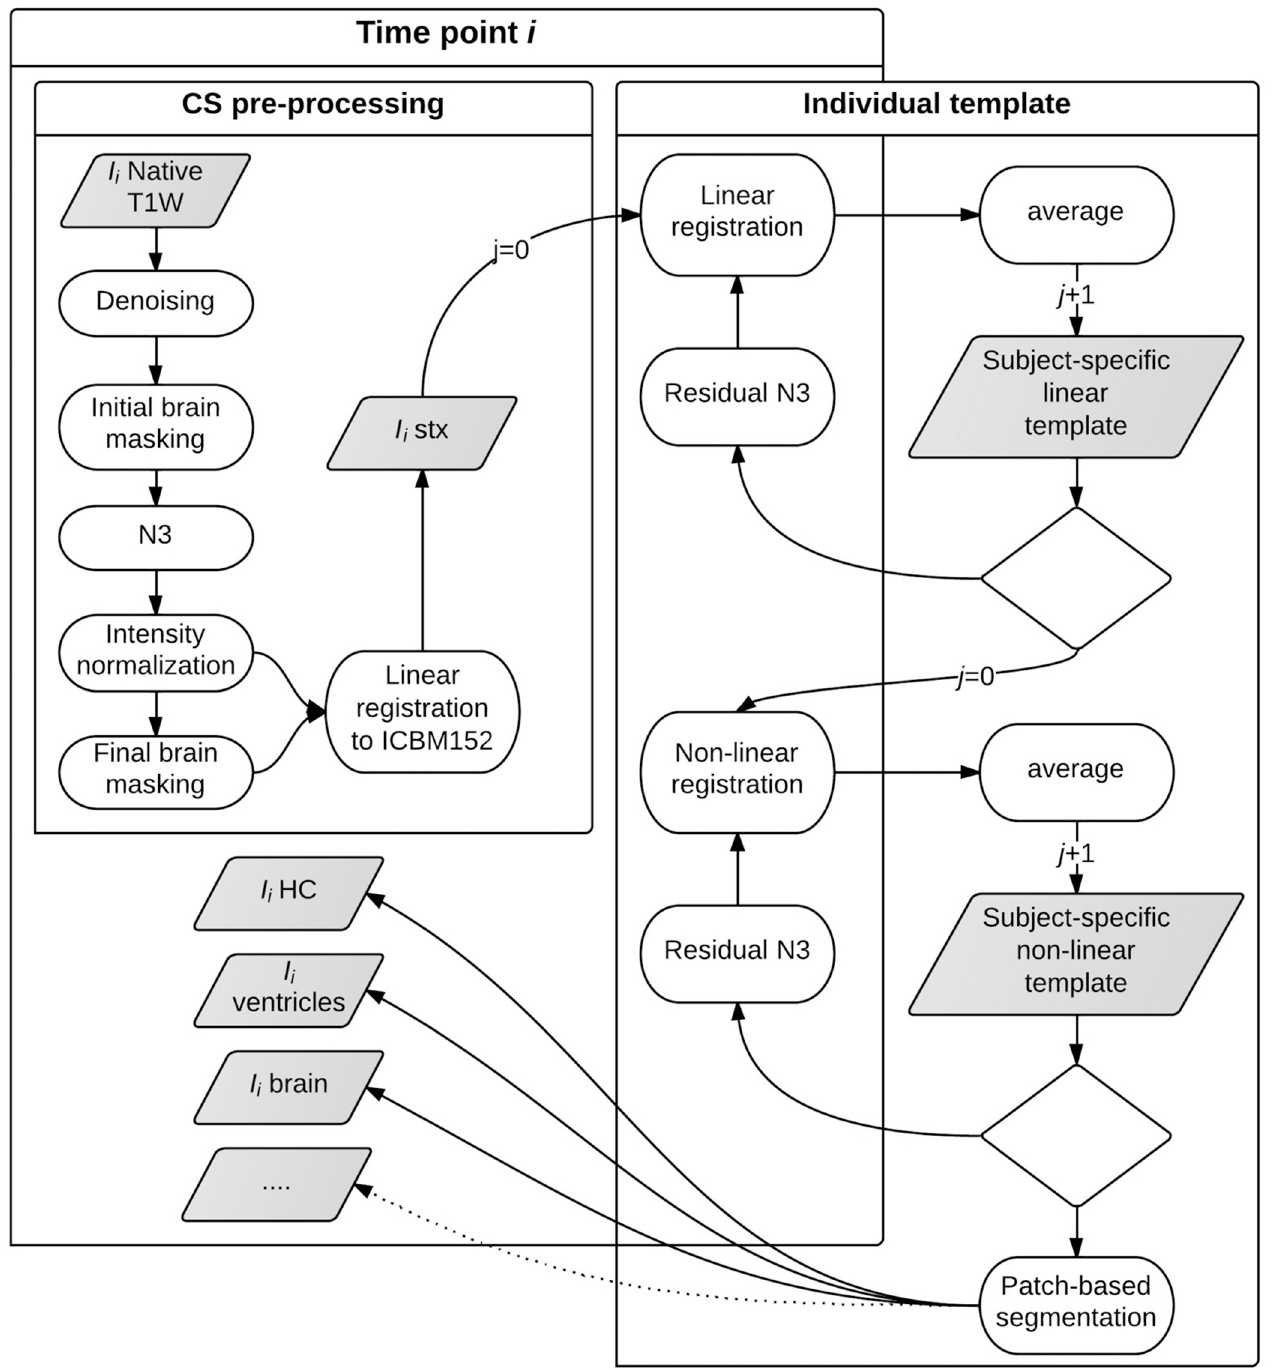
Fig 2. Longitudinal pipeline diagram. The different steps performed on each subject time-points are represented in the left part of the diagram, where the processes in the left small square represents the cross-sectional (CS) part of the pipeline. The individual template (IT) creation (linear and non-linear) is represented in the right side of the